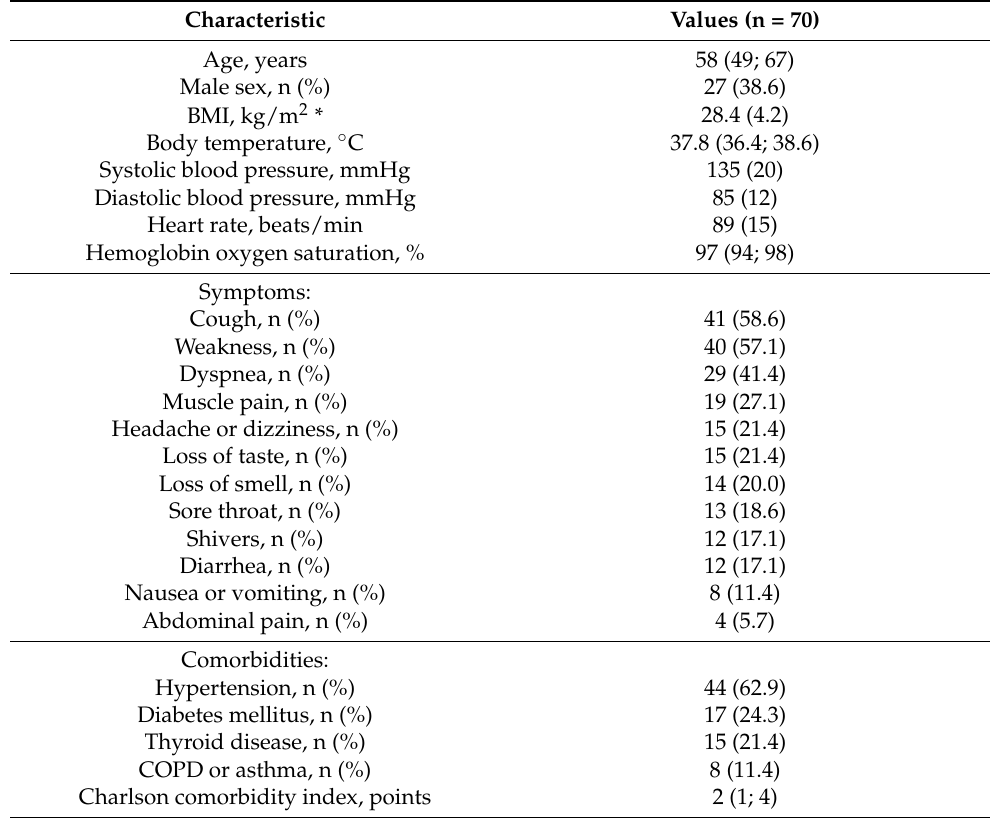
Table 1. Demographic and clinical characteristics of the studied patients on admission. Quantitative data are shown as median (IQR) or mean (SD).